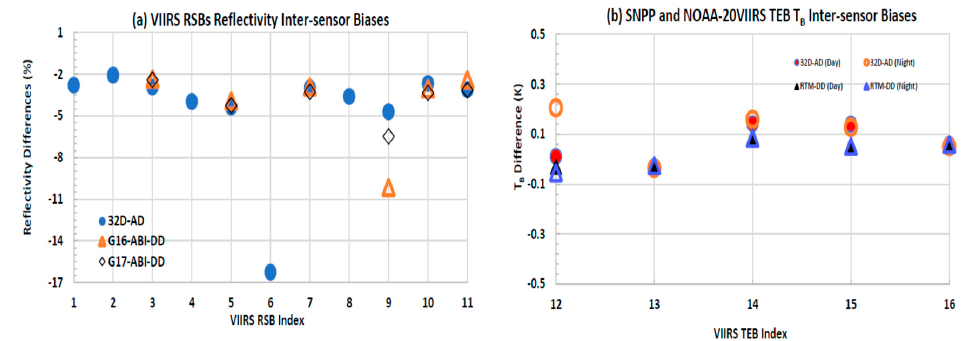
Figure 16. Comparison of the SNPP and NOAA-20 VIIRS inter-sensor calibration radiometric biases at M-bands using the methods of 32D-AD, ABI-DD, or CRTM-DD. ( a ) Reflectivity difference (%) at 11 RSB bands using the 32D-AD and